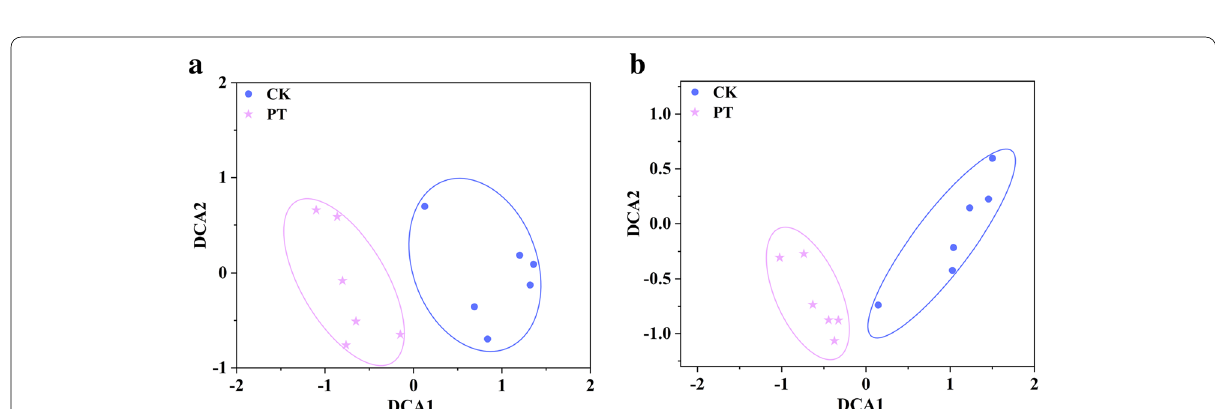
Fig. 2 Detrended correspondence analysis (DCA) of microbial community structures of tobacco rhizospheres with the CK and PT treatments ( a bacterial community, b fungal